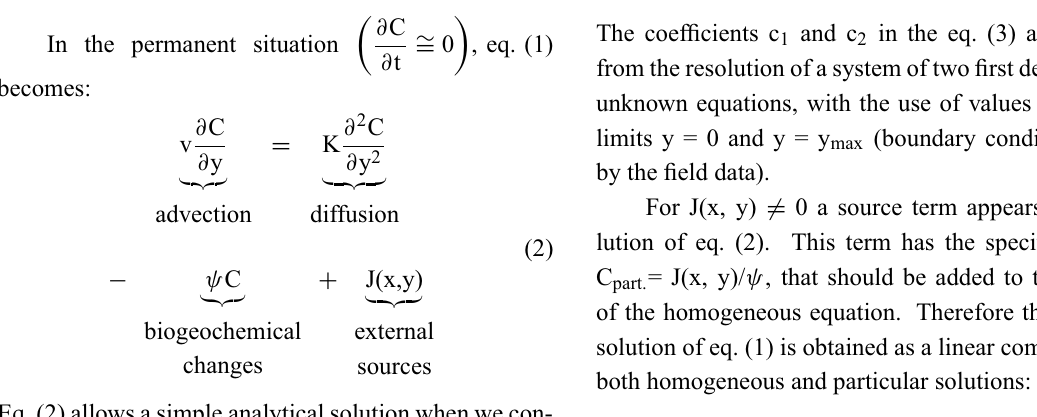
Fig. 1 – Map of the study area, showing the stations sampled during Operation North IV (Brazilian REVIZEE